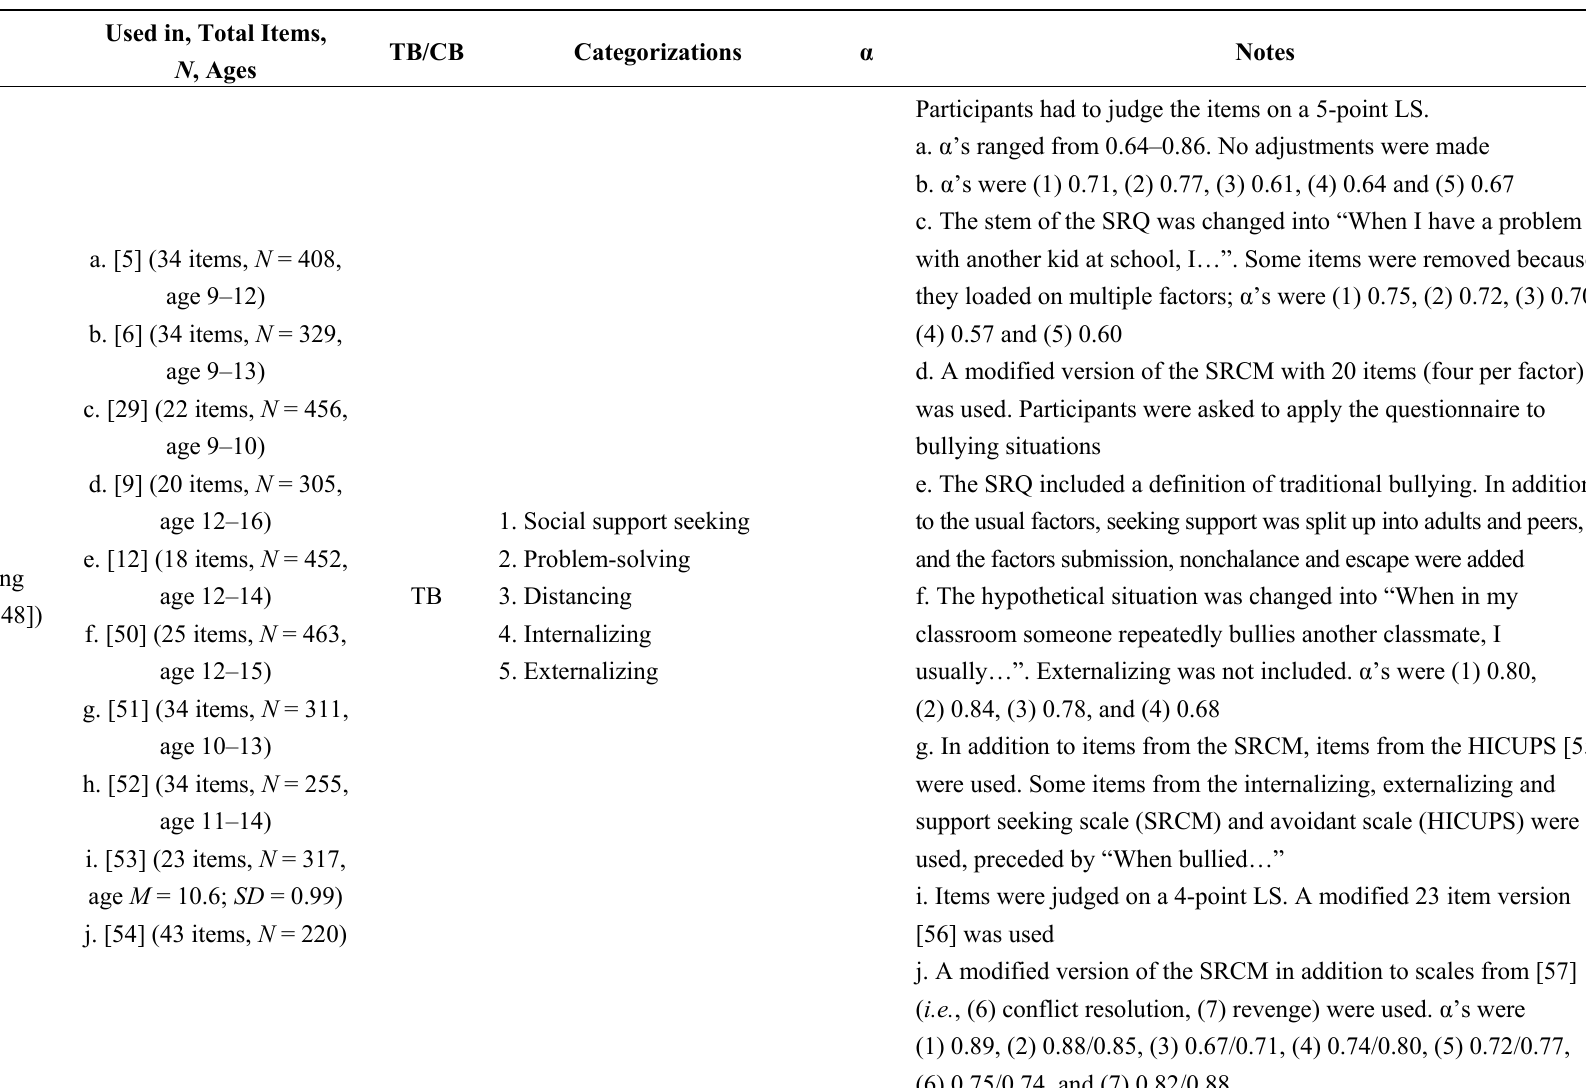
Table 1. Characteristics of self-report coping questionnaires used in (cyber)bullying research among